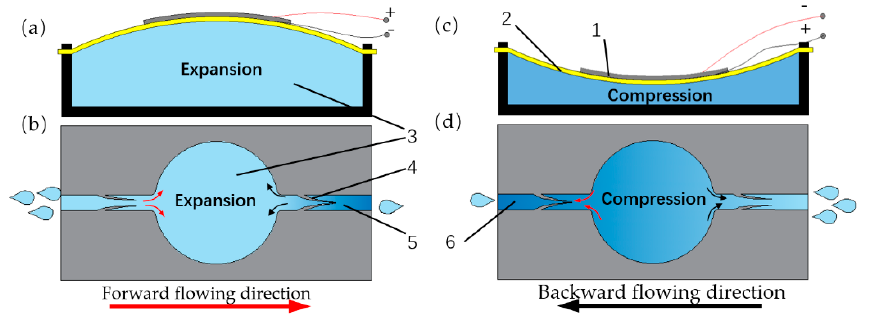
Figure 1. The working principle of the proposed Lead Zirconate Titanate (PZT) pump: ( a ) the pump chamber in suction stroke; ( b ) the inhaling principle during suction stroke; ( c ) the pump chamber in compression stroke; ( d ) the exhausting principle during compression stroke; (1) the piezoelectric ceramic; (2) the brass substrate; (3) the pump chamber; (4) the compliant structure; (5) the outlet channel; (6) the inlet channel.